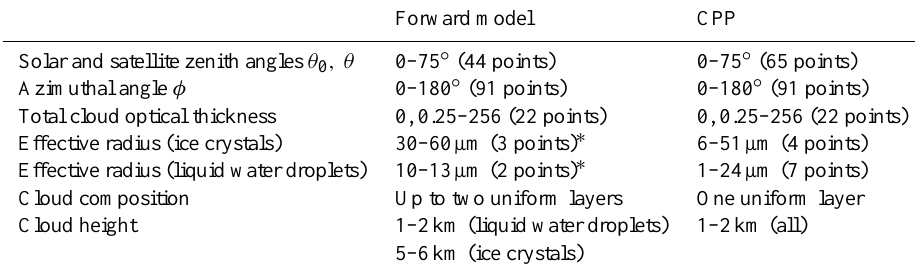
Table 1. Details of the lookup tables used in the forward model and the CPP retrieval